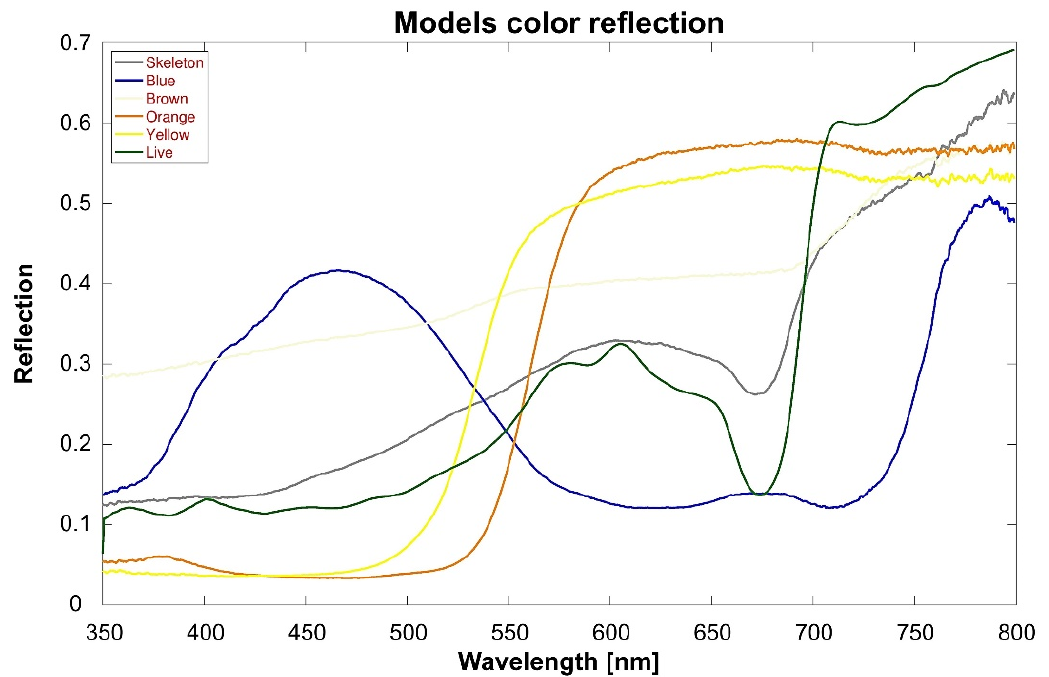
Figure 2. Re fl ectance spectra taken from the shelters. Figure 2. Reflectance spectra taken from the